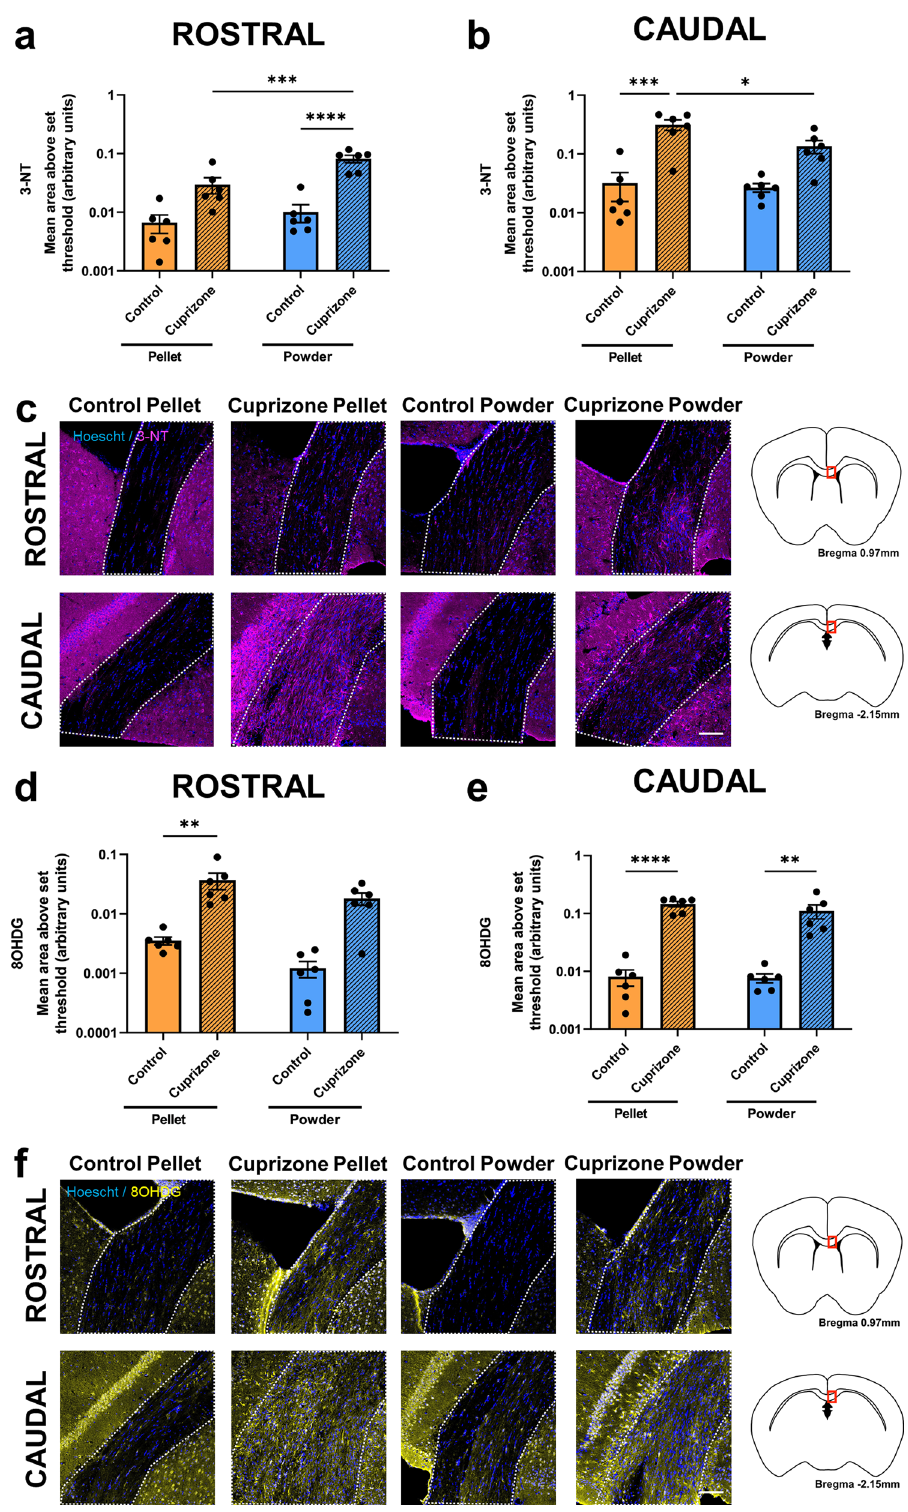
Figure 3. Effects of cuprizone feed formulation on oxidative stress. Area of immunointensity of 3-NT in the rostral ( a ) and caudal ( b ) corpus callosum was assessed to determine the level of protein nitration. Area of immunointensity of 8OHDG in the rostral ( d ) and caudal ( e ) corpus callosum was assessed to determine the level of oxidative DNA damage. N = 6 mice per group, graphs display individual data points overlayed on a bar displaying the mean ± SEM. Significant differences are indicated by *p ≤ 0.05, **p ≤ 0.01, ***p ≤ 0.001, ****p ≤ 0.0001. Representative images of the area of 3-NT ( c ) and 8OHDG ( f ) immunoreactivity are shown, scale bars = 100 µm. Area of the corpus callosum analysed is denoted by dotted lines. This area is indicated by the red box in the coronal overviews illustrating the rostral and caudal regions of the corpus callosum ( c , f ). The stereotaxic coordinates are